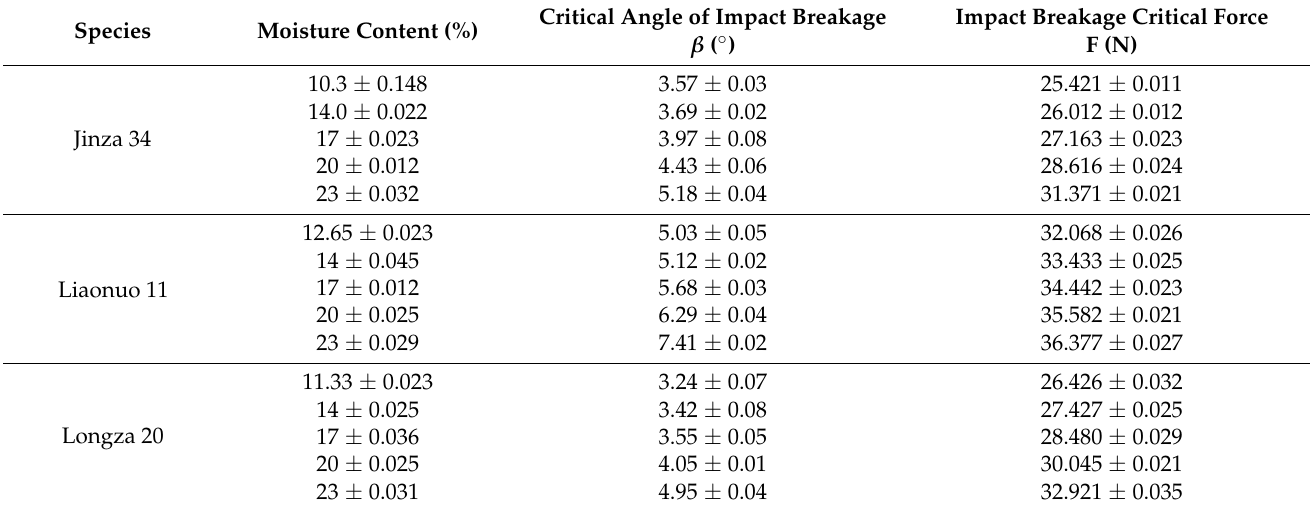
Table 5. Results of impact tests with different varieties of sorghum seeds at different moisture contents.